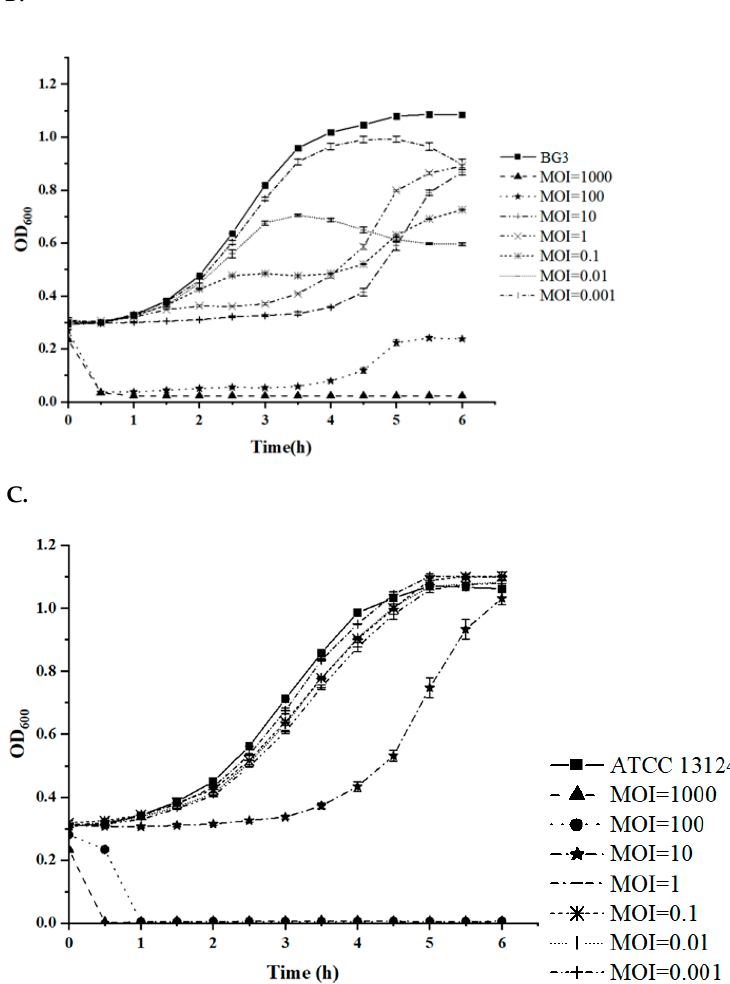
Figure 4. Adsorption and lytic activity of phage BG3P. ( A ) Adsorption of phage BG3P to C. perfringens BG3 within 30 min with MOI 0.01. ( B ) Inhibitory effect of phage BG3P against C. perfringens BG3 at different MOIs. 1 × 10 10 ( ), 1 × 10 9 ( ), 1 × 10 8 ( ), 1 × 10 7 ( ), 1 × 10 6 ( ), 1 × 10 5 ( ), 1 × 10 4 ( ) log PFU/mL. The initial concentration of C. perfringens BG3 is 10 7 CFU/mL ( ). Values are the mean of three determinations. ( C ) Inhibitory effect of phage BG3P against C. perfringens ATCC 13,124 at different MOIs. 1 × 10 10 ( ), 1 × 10 9 ( ), 1 × 10 8 ( ), 1 × 10 7 ( ), 1 × 10 6 ( ), 1 × 10 5 ( ), 1 × 10 4 ( ) log PFU/mL. The initial concentration of C. perfringens ATCC 13,124 is 10 7 CFU/mL ( ). Values are the mean of three determinations.